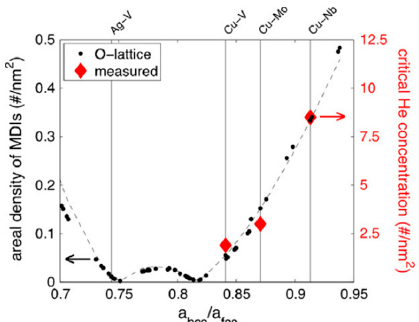
Figure 13. Black dots show the dependence of areal densities of MDIs calculated using O-lattice theory on lattice parameter ratios in FCC/BCC interfaces with identical interface orientation relationship. Red diamonds represent the critical He concentration to form visible He bubbles with different lattice parameter ratios. Reprinted with permission from [95]; Copyright 2012 Elsevier.